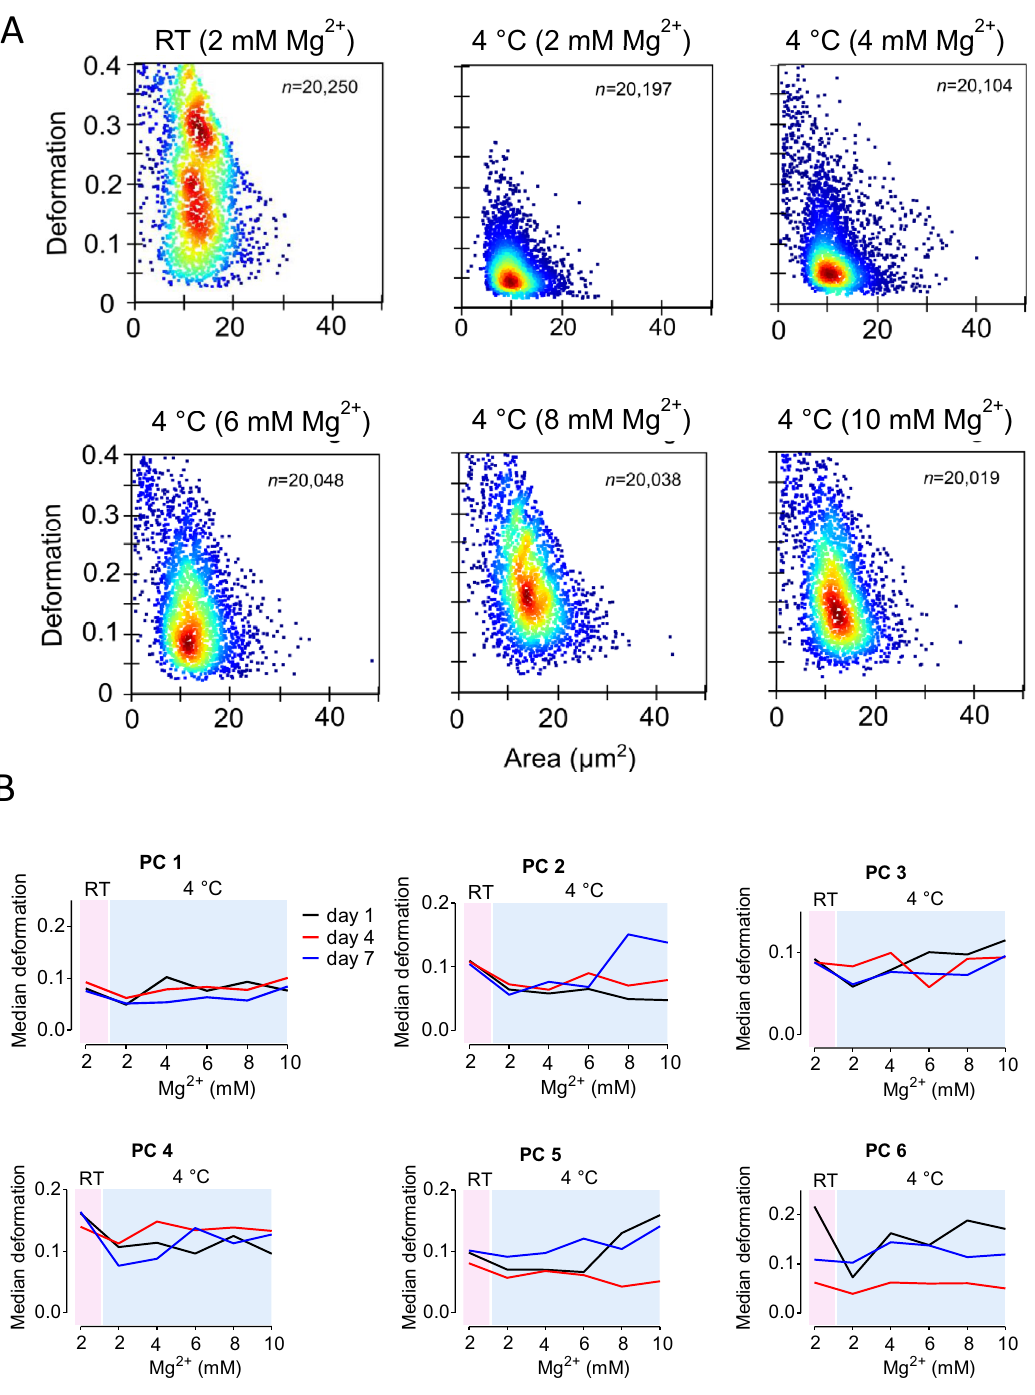
Figure 2. ( A ) Deformation vs cell area scatterplots determined by RT-DC of platelets from one PC stored for 7 days under different conditions at RT + 2 mM Mg 2+ , 4 °C + 2, 4, 6, 8 or 10 mM Mg 2+ . ( B ) Median deformation of platelets in platelet concentrates (PC, n = 6) for each magnesium concentration and storage temperature are given for day 1 (black), day 4 (red) and day 7 (blue), n ≥ 20,000 platelets. RT room temperature, Mg 2 +